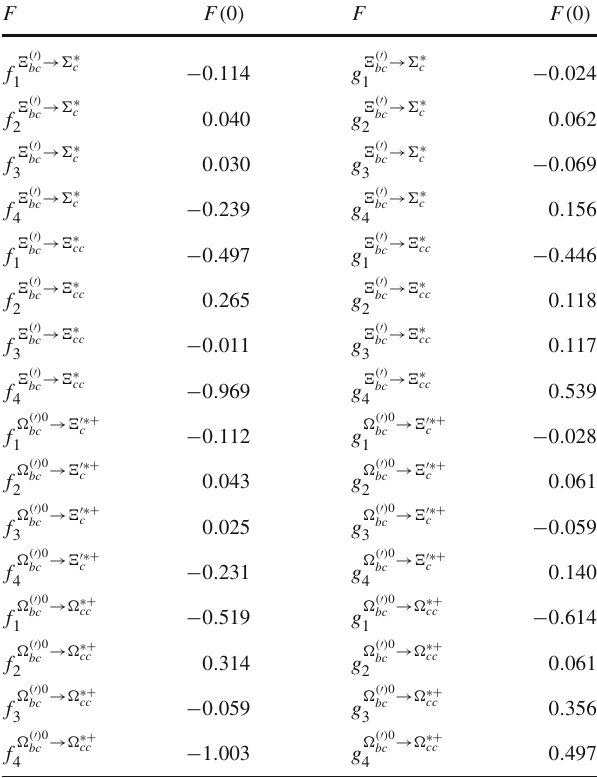
Table 9 Same as Table 7 but for the bc ( (cid:3) ) sector with b quark decay